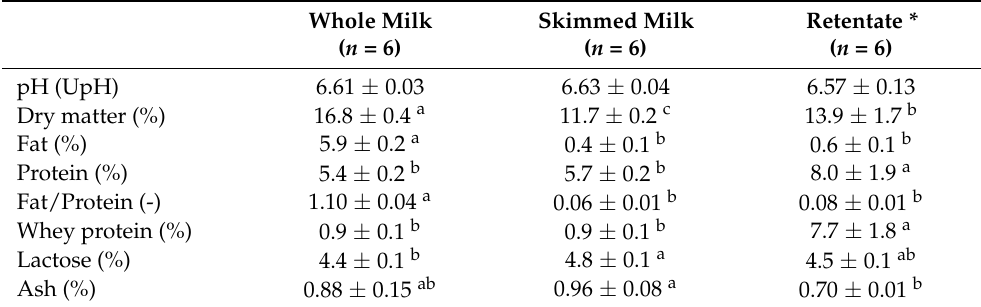
Table 1. Chemico-physical composition of the dairy ingredients used to produce the liquid milk- derived formulations (mean ± SD).